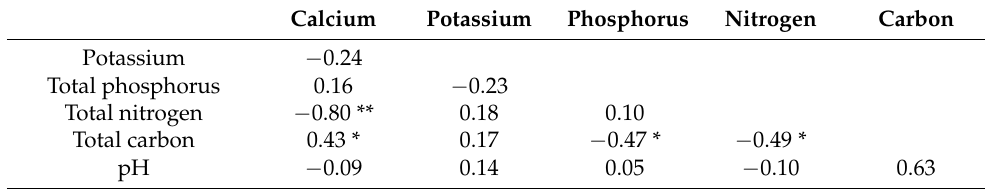
Table 2. Correlation coefficients of bottom soil properties of seawater ponds at Garho Fish Farm.